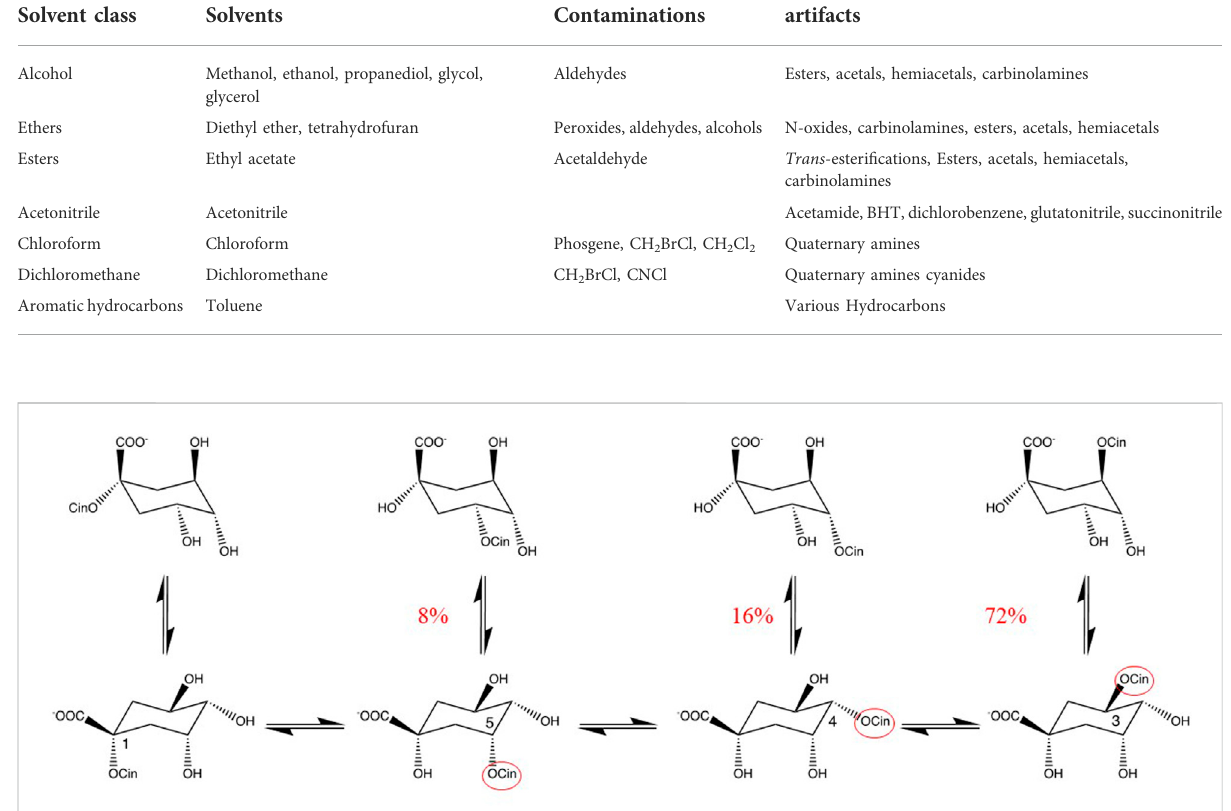
TABLE 1 The example of impurities and reactions of the solvents most commonly used in phytochemistry.